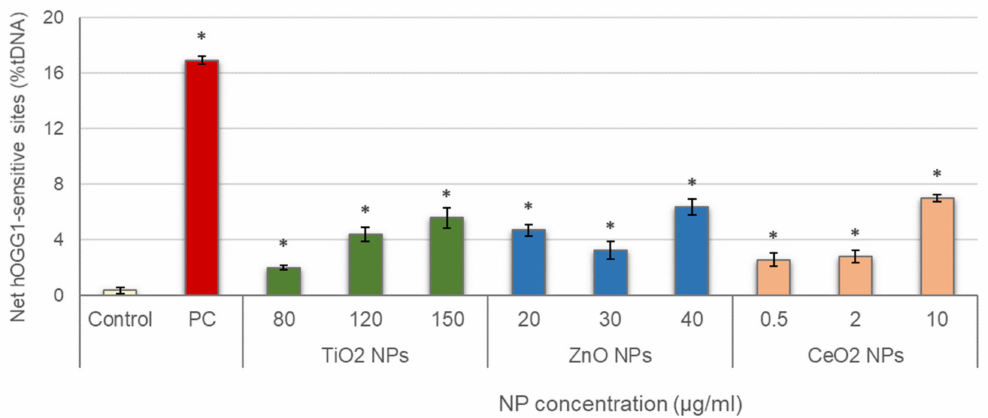
Figure 4. Results of oxidative DNA damage induced in salivary leucocytes exposed to TiO 2 , ZnO and CeO 2 NPs. PC: positive control (335 µ g/mL KBrO 3 for 1 h). Columns represent mean values and error bars indicate the standard errors. * p < 0.01, significant difference with regard to the